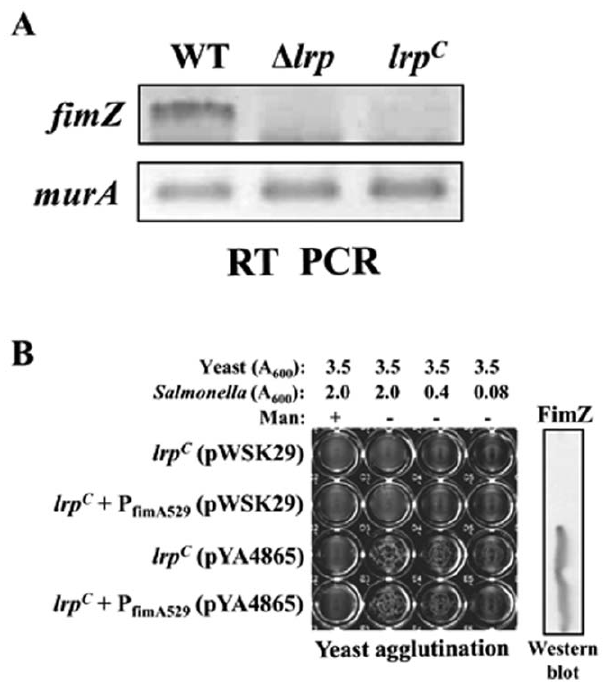
Figure 6. Effect of cellular Lrp levels on FimZ synthesis and P fimA -FimZ interaction in Salmonella . (A) RT-PCR analysis of fimZ transcript in the wild-type (WT, x 3761), D lrp ( x 9411), and lrp C ( x 9448) strains. RT-PCR analysis of murA transcript in the strains was used as the control. (B) Mannose-sensitive yeast agglutination assay to assess type 1 fimbriae production and western bolt analysis for the FimZ synthesis in the lrp C mutants harboring pWSK29 (a low-copy number vector control) or pYA4865 (Lrp-independent fimZ expression vector).